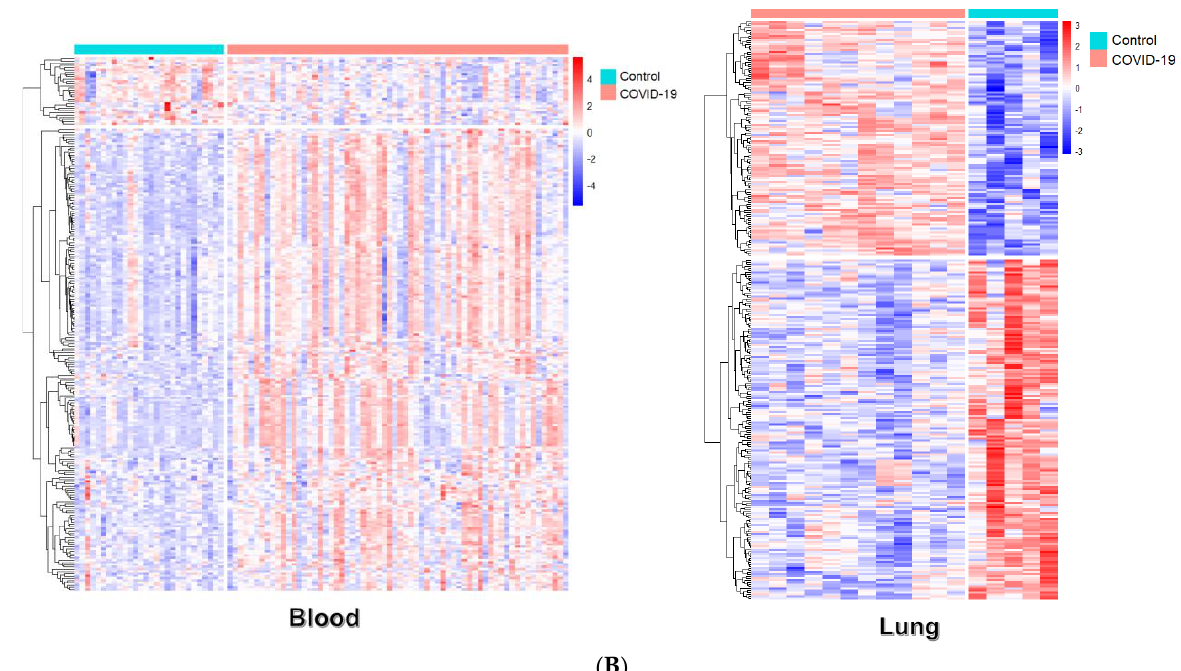
Figure 2. Genes differentially expressed between SARS-CoV-2-infected and control samples. ( A ) PCA of COVID-19 and control samples from blood and lung tissues. Red and blue ellipses represent COVID-19 and control samples, respectively. ( B ) Heatmap of the DEGs in blood and lung tissues. COVID-19 and control samples are shown in salmon and turquoise colors, respectively. Each row corresponds to a DEG. The upregulated and downregulated genes are indicated by red and blue colors, respectively. A dendrogram depicting hierarchical gene clustering (based on Z-scoring) is shown on the left.